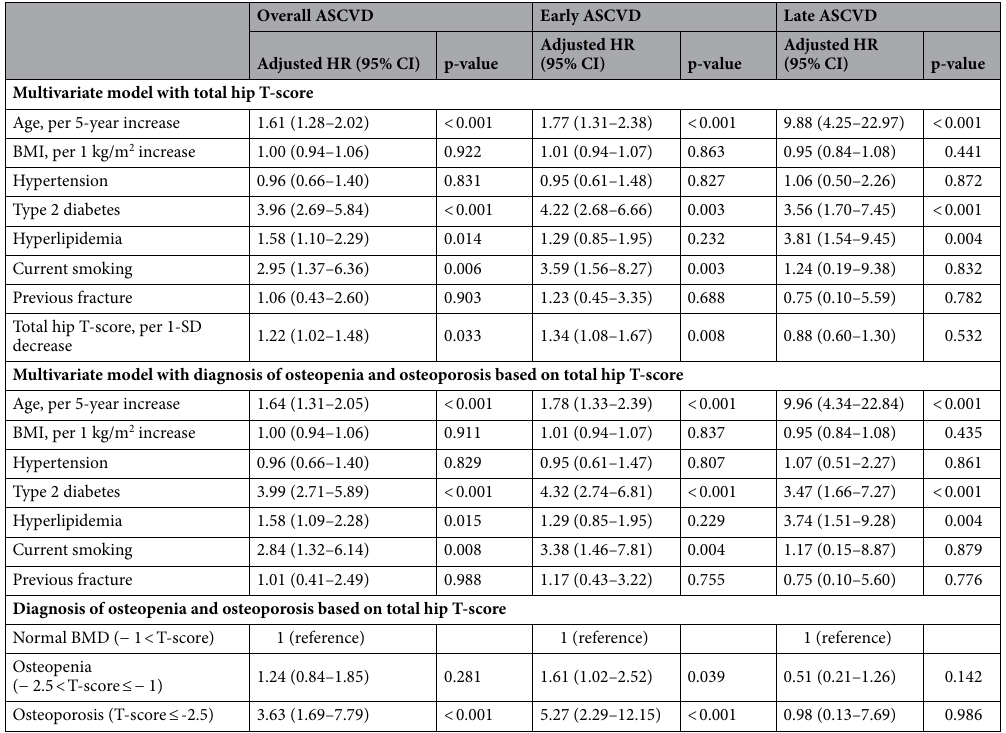
Table 3. Multivariate assessment of independent predictors for ASCVD. ASCVD atherosclerotic cardiovascular disease, BMD bone mineral density, BMI body mass index, CI confidence interval, HR hazard ratio, SD standard